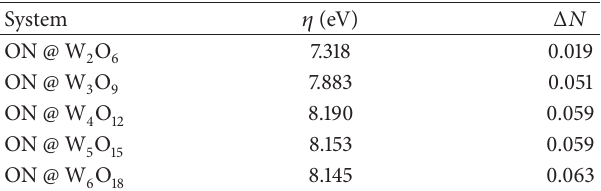
Table 2: Calculated quantum reactivity indices for NO